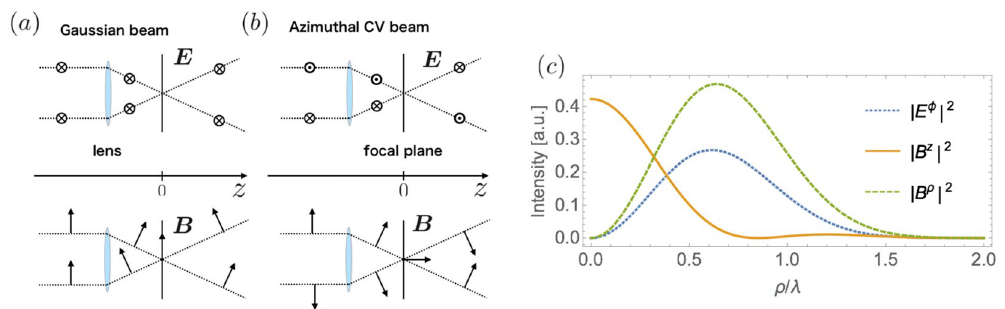
Figure 3. ( a , b ) Focusing of the Gaussian beam and the azimuthal CV beam with a high numerical aperture lens. The characteristic spatial profile of the polarization vector of the azimuthal beam results in the vanishing electric field and the growth of the longitudinal magnetic field near the focus. ( c ) Intensity distribution of the azimuthal beam in the focal plane at z = 0. The horizontal axis is the distance from the center of the focal